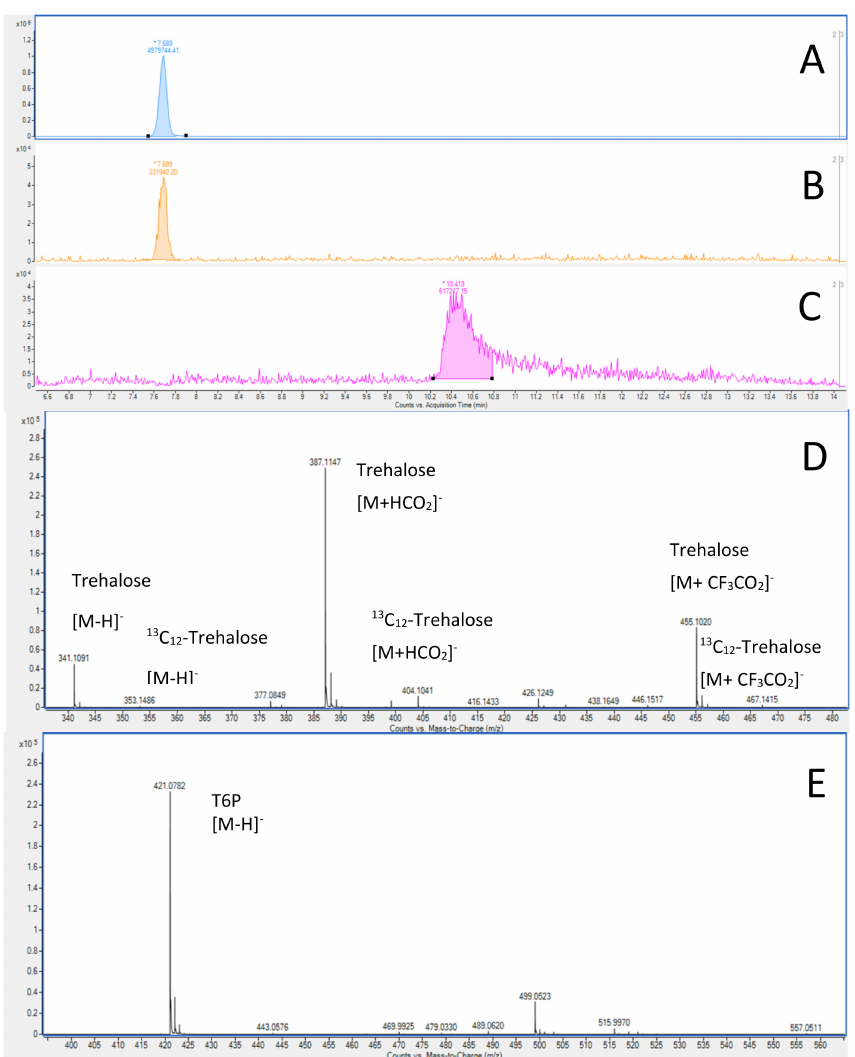
Figure 3. Extracted ion chromatogram of [M − H] − cluster of trehalose ( A ), 13 C 12 trehalose ( B ), and T6P ( C ), their ESI-HRMS spectra for trehalose, its internal standard ( D ), and for T6P ( E ). * Saturation of TOF